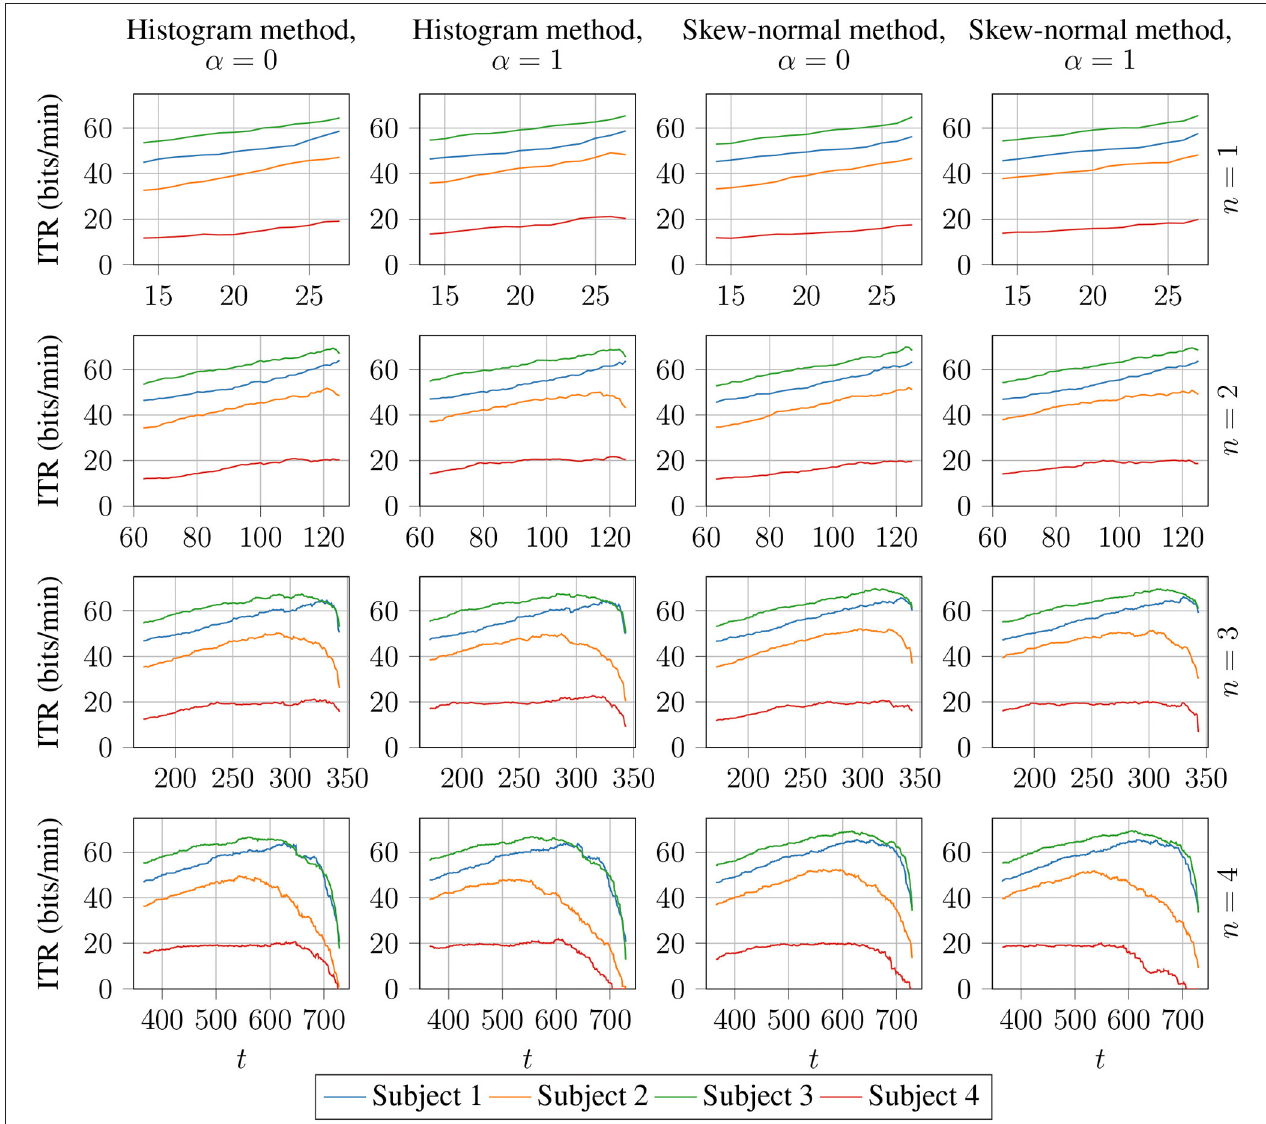
FIGURE 3 | ITR (6) calculated on Dataset 1 for Classifier 2 with n refer to the methods of estimating probabilities as described in section 2.5.